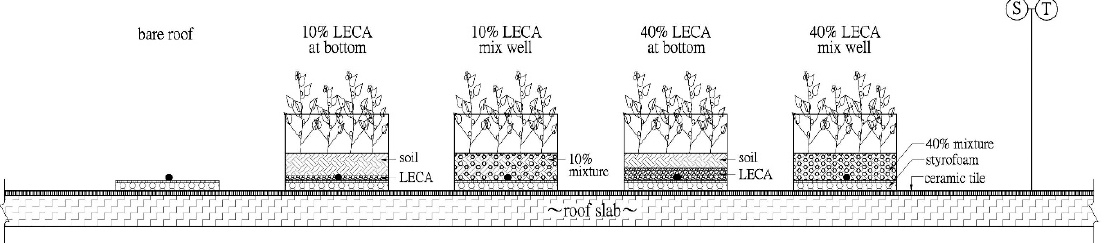
Figure 16. Experimental setup for the fourth stage.